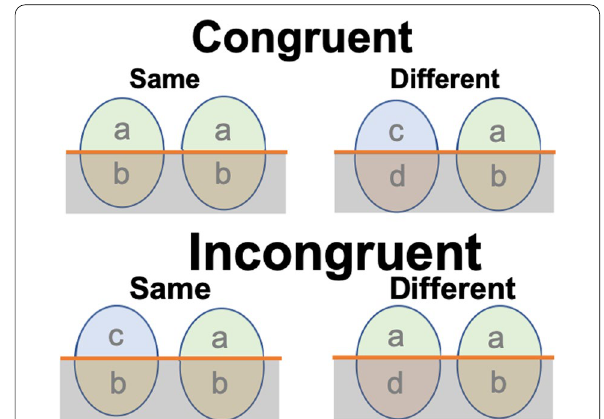
Fig. 1 Complete composite paradigm to measure holistic processing for face stimuli. In each trial, participants were cued to attend to the top or bottom half of each stimulus pair and judged whether the attended halves were the same or different (attended halves encircled by the red rectangles in the figure). Holistic processing was demonstrated by a lower performance level in the incongruent condition than in the congruent condition, induced by the interference of the irrelevant/unattended